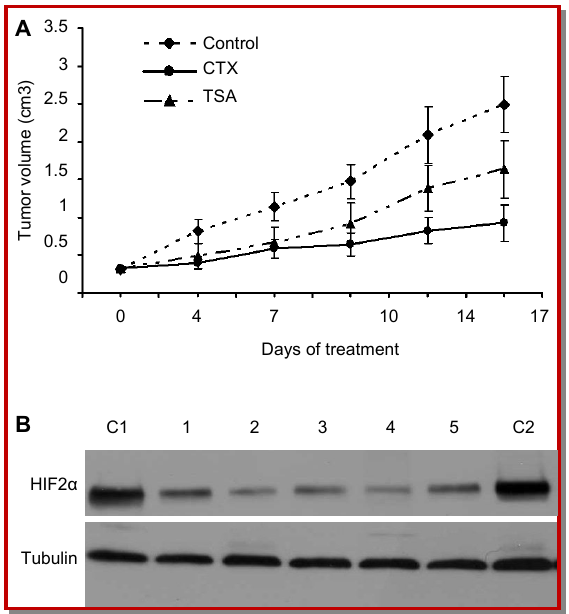
Figure 3: Effect of TSA on tumor growth and HIF-2 α expres- sion in vivo (A) MG-63 cells were inoculated into nude mice to induce subcutaneous tumors. One week later, mice were randomly divided into control, TSA and CTX groups, in which mice were treated with normal saline (control group), TSA and CTX, respectively, for 17 days. Data were expressed as mean ± standard error (SEM). (B) Tumors were harvested and homogenized; protein was subjected to SDS-PAGE followed by immunoblotting for HIF-2 α and tubulin. C1, C2: control group; 1, 2, 3, 4, 5: TSA-treated